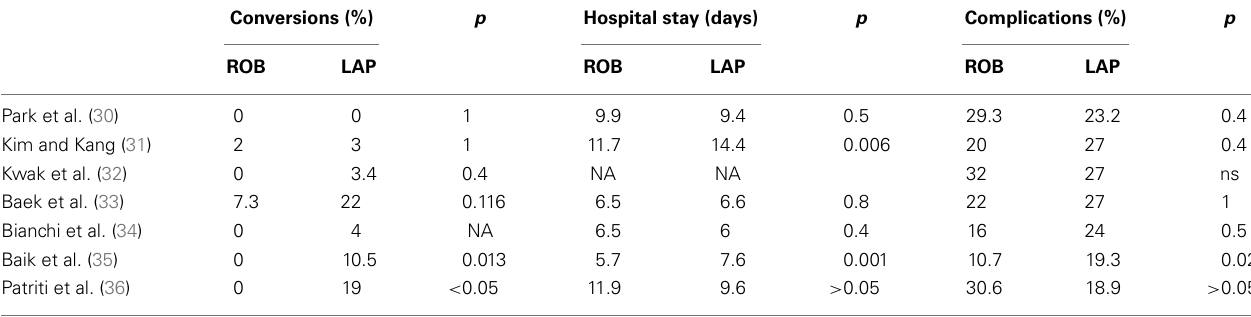
Table 3 | Clinical results of laparoscopic and robotic surgery for rectal cancer . Conversions (%) p Hospital stay